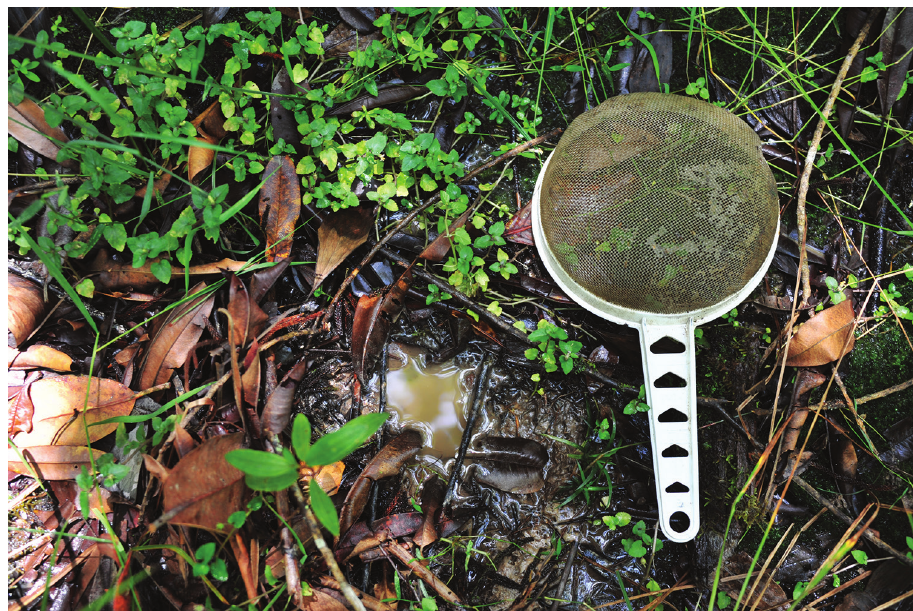
Figure 14. Wed forest ground, habitat of Exocelina okbapensis hajeki ssp. n. 10 km NE Wamena, forest above ‘Baliem vall. Resort’. Photo by Jiří